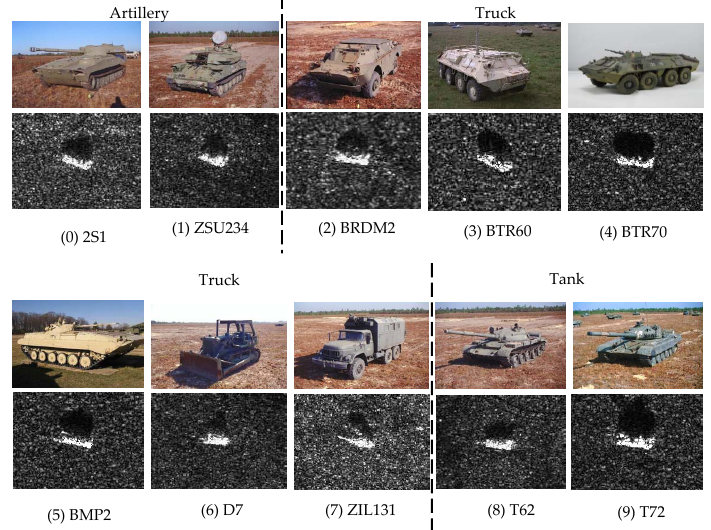
Figure 3. Optical images and corresponding Synthetic Aperture Radar (SAR) images of ten classes of objects in the Moving and Stationary Target Acquisition and Recognition (MSTAR) database.